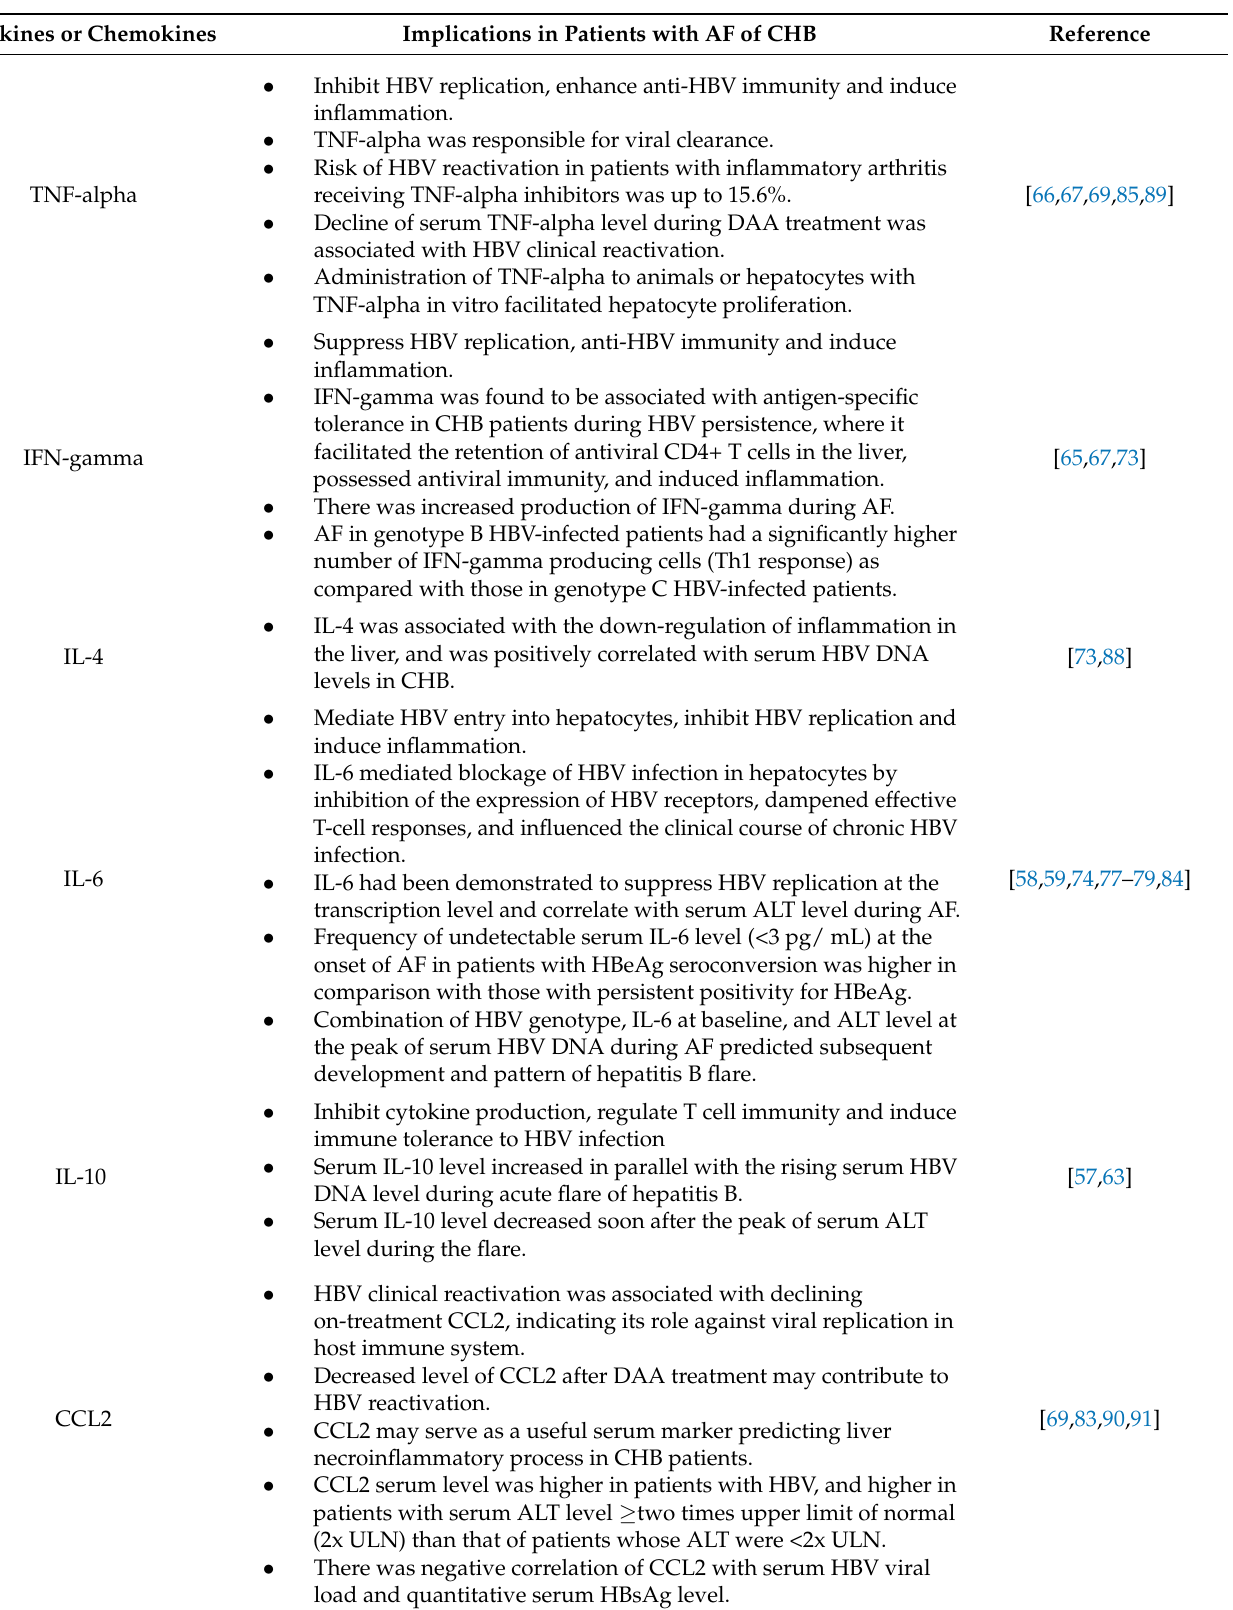
Table 2. Findings and implications of various serum cytokines and chemokines in patients with acute flare of chronic hepatitis B in various clinical